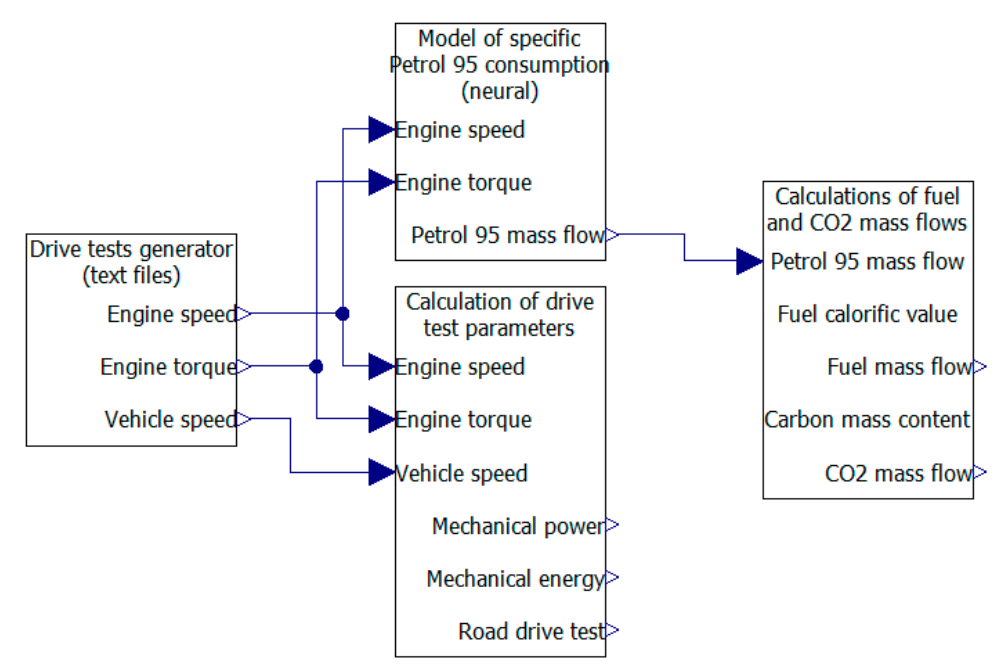
Figure 5. A general schematic of the driving test simulator, including biofuels OpenModelica v1.16.2 software.